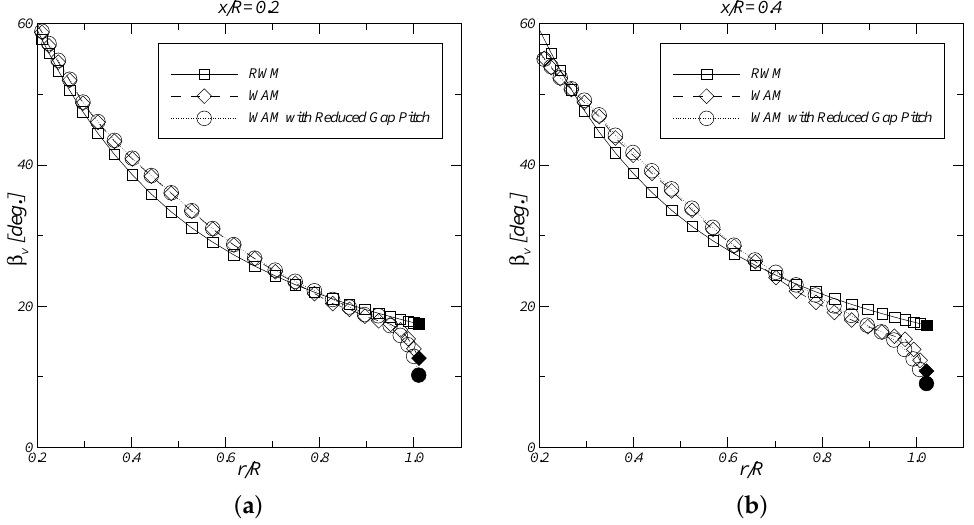
Figure 7. Vortex pitch β v distribution at x / R = 0.2 ( a ) and x / R = 0.4 ( b ) for J = 0.2. Influence of the wake model. The filled symbols refer to the tip